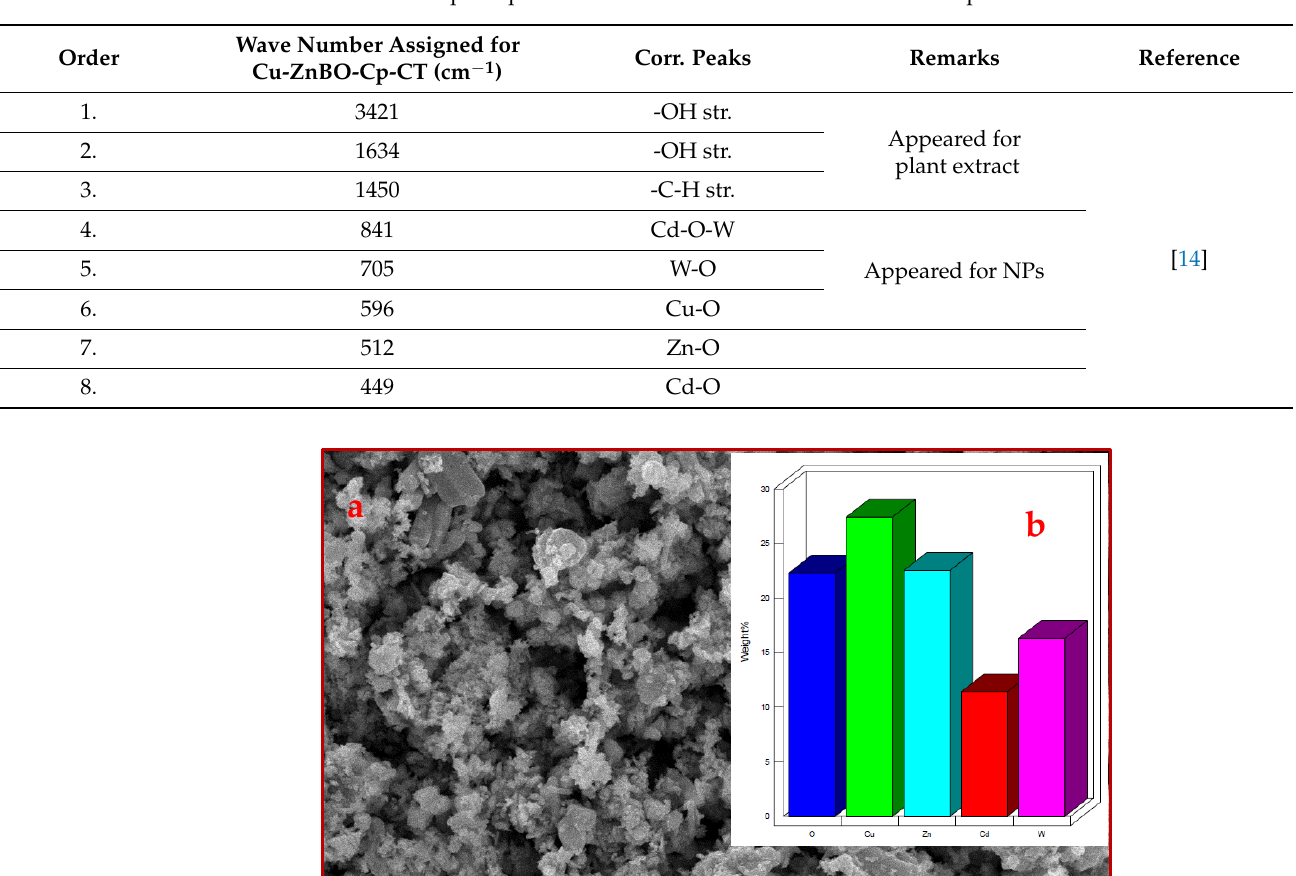
Table 2. FTIR absorption peaks at various wavenumber for Cu-ZnBO-Cp-CT.